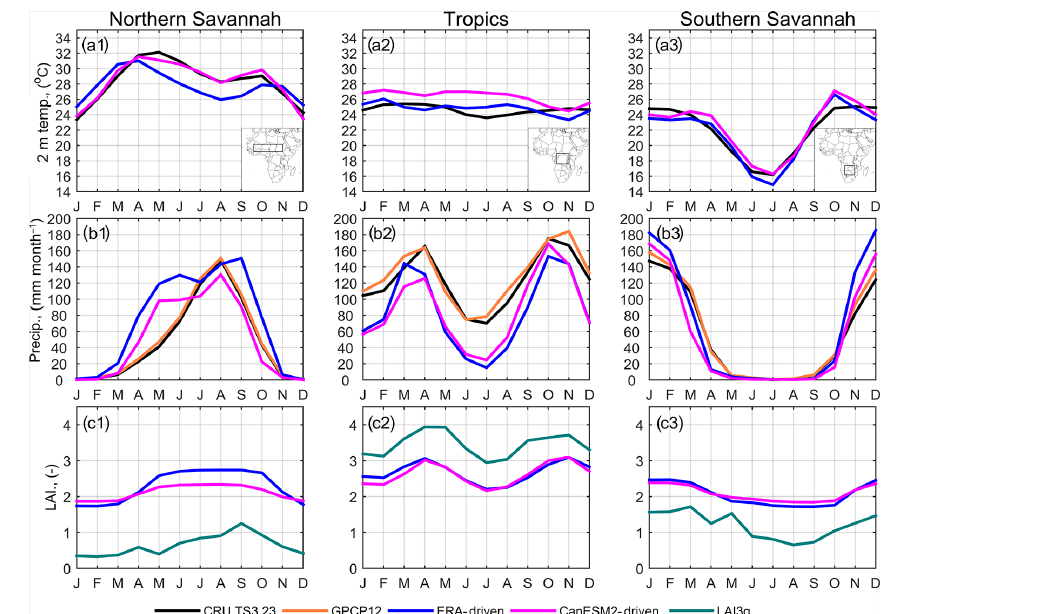
Figure 2. Simulated seasonal cycle and observations for northern savannah (inset in a1 ), central Africa (inset in a2 ) and southern savannah (inset in a3 ) for the period 1997–2010. Two-metre temperature (a1–a3) and precipitation (b1–b3) are as in Fig. 1. For LAI (c1–c3) monthly mean tile-weighted simulated LAI over the averaging period is used to compare with the